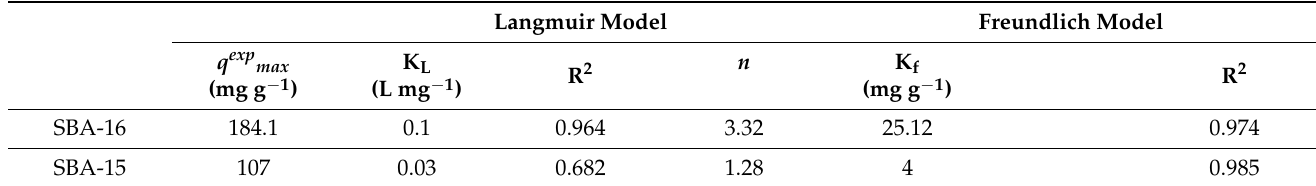
Figure 11. Langmuir and Freundlich adsorption isotherms for Zn 2+ adsorption on EDTA-modified SBA-16 and SBA-15. Table 4. Langmuir and Freundlich models for Zn 2+ adsorption on SBA-16 and SBA-15.